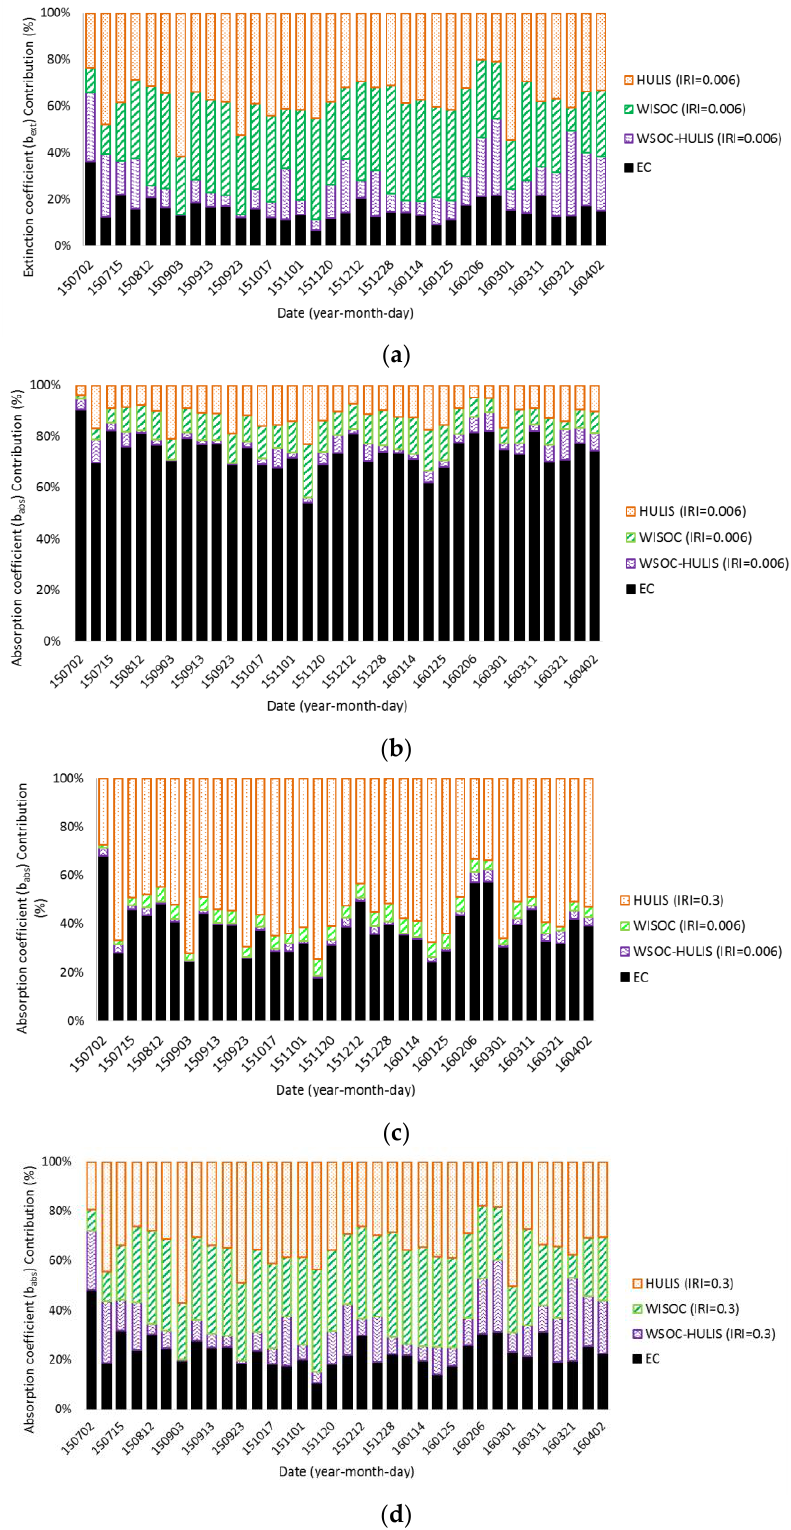
Figure 3. Contribution of each carbonaceous component to the daily averaged optical properties. ( a ) Extinction coefficient when IRI = 0.006; ( b ) absorption coefficient when IRI = 0.006; ( c ) absorption coefficient when IRI = 0.3 for HULIS; and ( d ) absorption coefficient when IRI = 0.3. Size parameters are fixed, d g = 0.1 µm, for EC and 0.5 µm for organic aerosols, and σ g = 1.5.